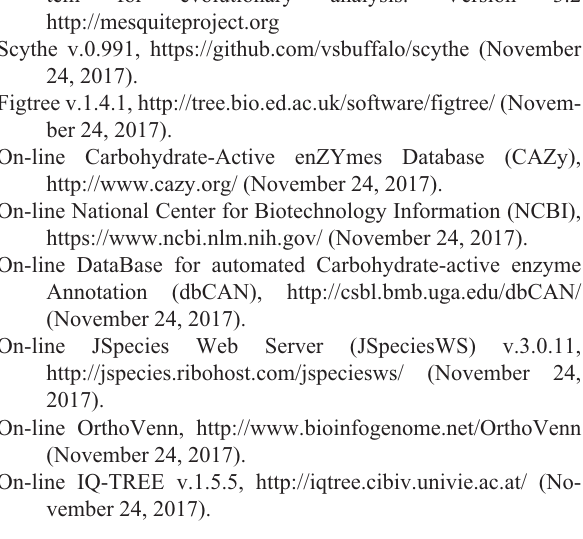
Figtree v.1.4.1, http://tree.bio.ed.ac.uk/software/figtree/ (Novem-